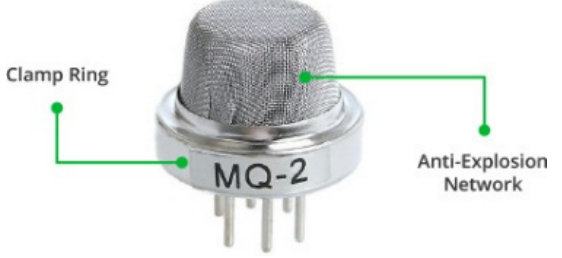
Figure 6. Smoke Sensor MQ2.